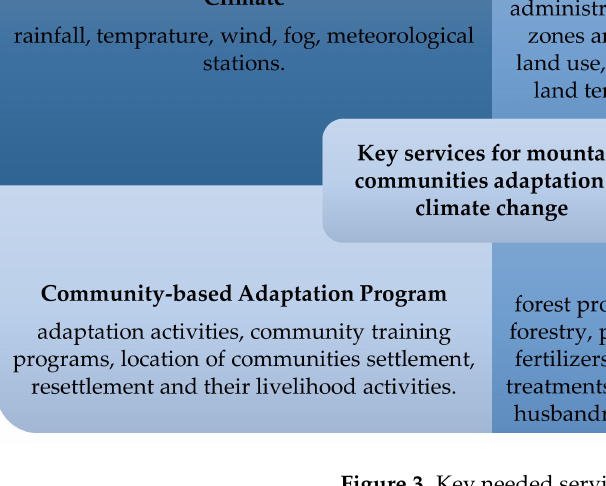
Figure 3. Key needed